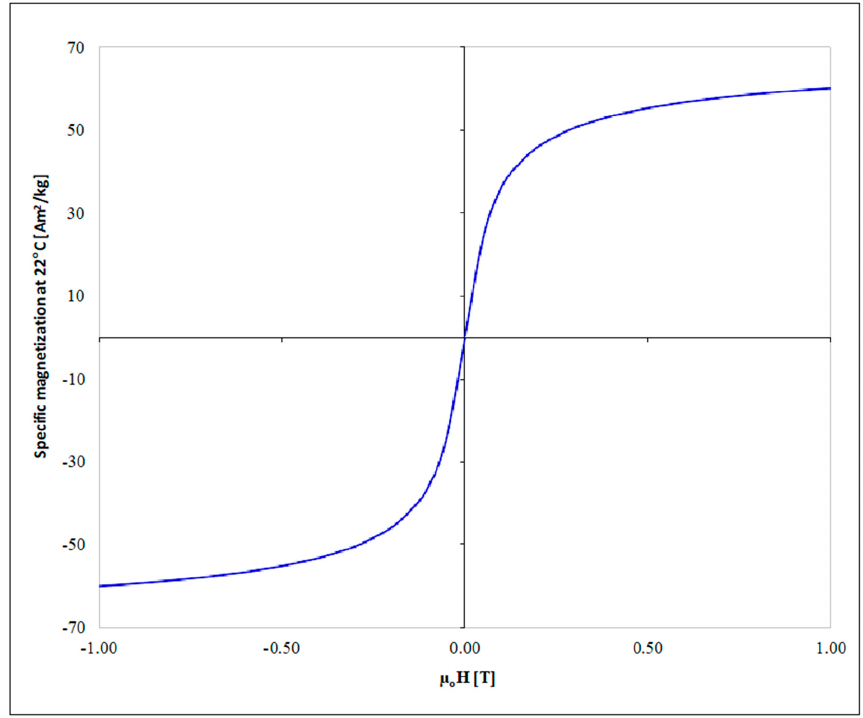
Figure 2. Magnetization curve for the synthesized Fe 3 O 4